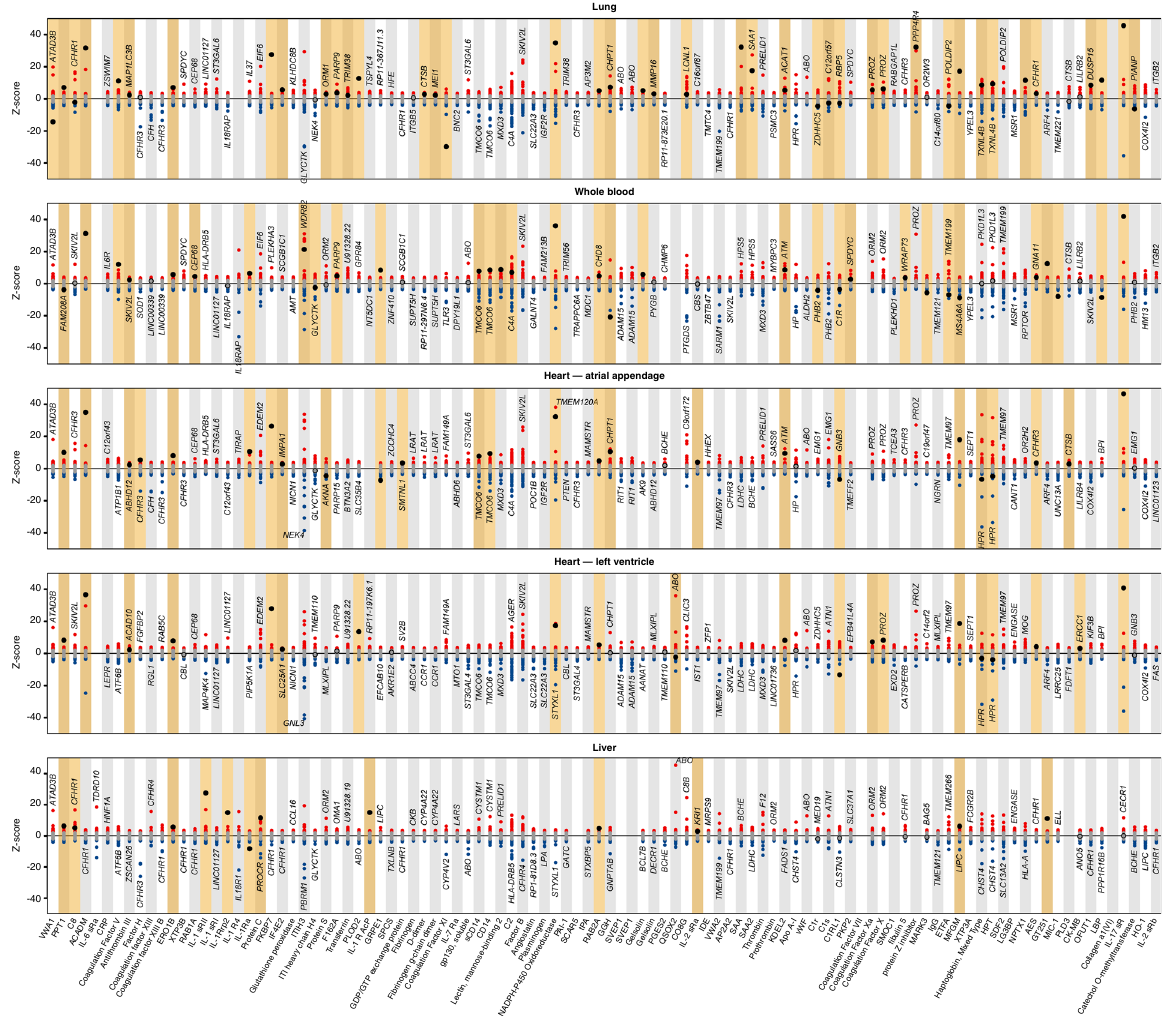
Fig. 5 Results of predicted gene expression in each of fi ve tissues and plasma abundances of 102 aptamers with at least one cis -pQTL on one of the autosomes using PrediXcan. Each panel displays results for a tissue. Each column contains results across successful gene expression models for the association with the aptamer listed on the x -axis. Red indicates nominally signi fi cant ( p < 0.05) positive z -scores ( y -axis) and blue, nominally signi fi cant inverse z -scores for associated aptamers. Protein-encoding genes are highlighted by larger black circles. Orange background indicates all examples of signi fi cant associations between the protein-encoding gene and protein abundance in plasma regardless if this was the most signi fi cant one. Top genes were annotated if those differed from the protein-encoding